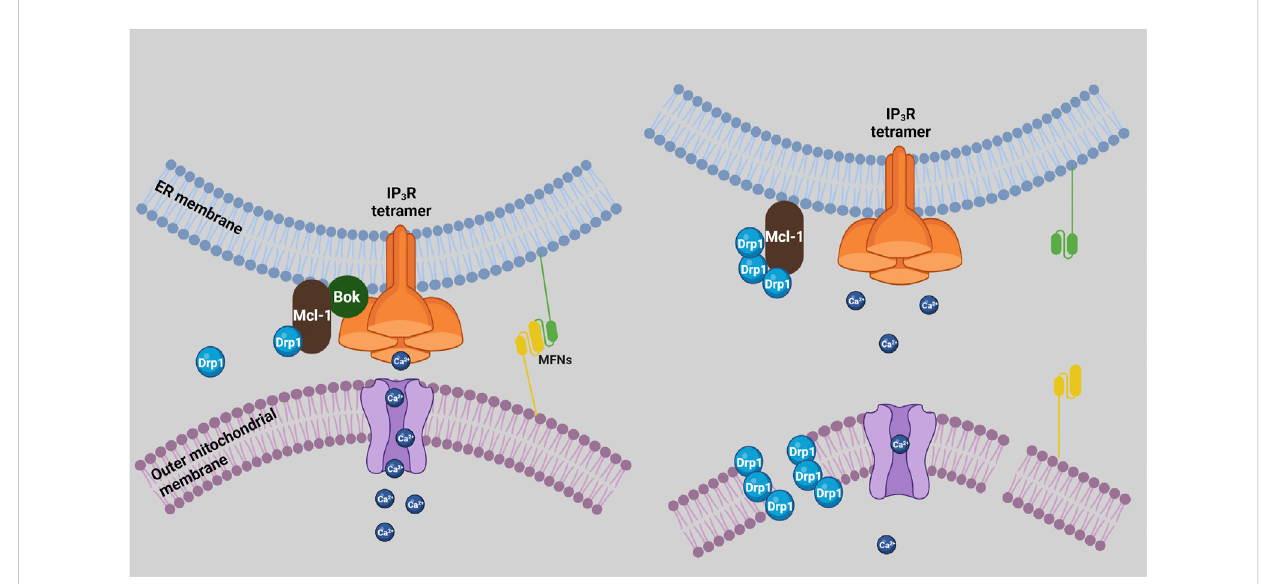
Bok regulation of MAMs and mitochondrial dynamics. In the presence of Bok (left), mitochondria and ER are in close proximity and form MAMs, mitofusins (MFNs) mediate ER/mitochondria tethering, Ca 2+ is ef fi ciently transferred to mitochondria, and Mcl-1 promotes Drp1 activity, which could be heldincheckbytheabilityofMcl-1tobindBok.IntheabsenceofBok(right),mitochondriaandERseparate,mitochondrialuptakeofCa 2+ isimpaired,and mitochondriabecomefragmented,duetomore fi ssionactivityand/orlessfusionactivity.Enhanced fi ssioncouldresultfromlessBokantagonismof Mcl-1 leading to more Drp1 activity, while less fusion could result from disruption of mitofusin interactions and